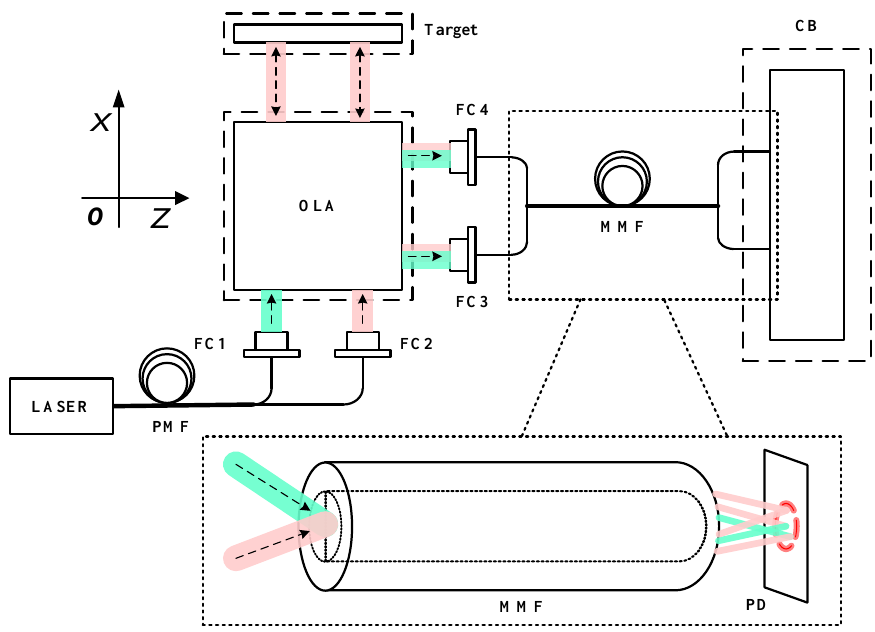
Figure 1. The schematic diagram of the interferometer measurement system with fiber-coupled delivery. The red beams are the measurement arms and the green beams are the reference